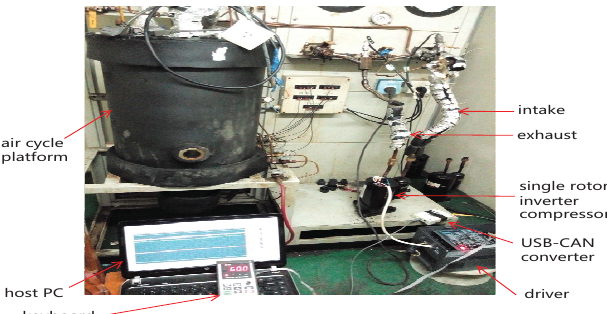
Figure 16. Experimental platform of inverter